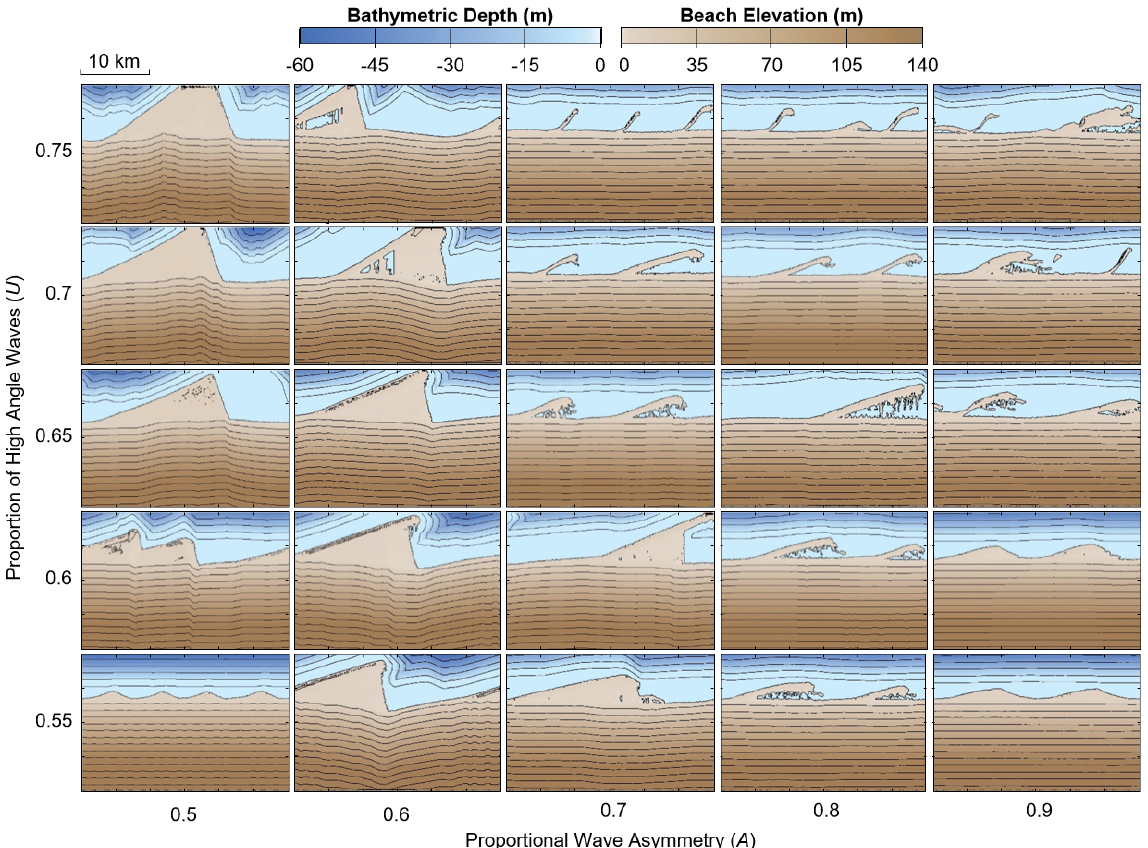
Figure 11. A matrix of results from CEM2D, showing two-dimensional final shoreline morphologies as a function of the wave angle asym- metry ( A ) and proportion of high-angle waves ( U ) approaching the coast relative to the local shoreline orientation. The outputs measure 20km in width and 30km in length and are not inclusive of the periodic boundaries.